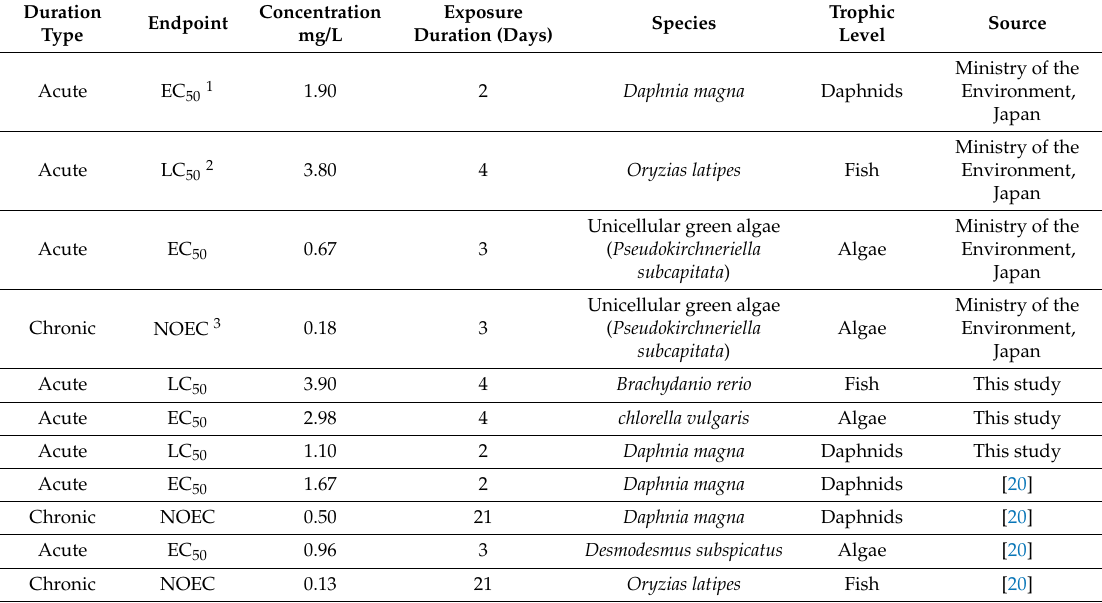
Table 4. Toxicity result of BP-3 (including the former data registered in